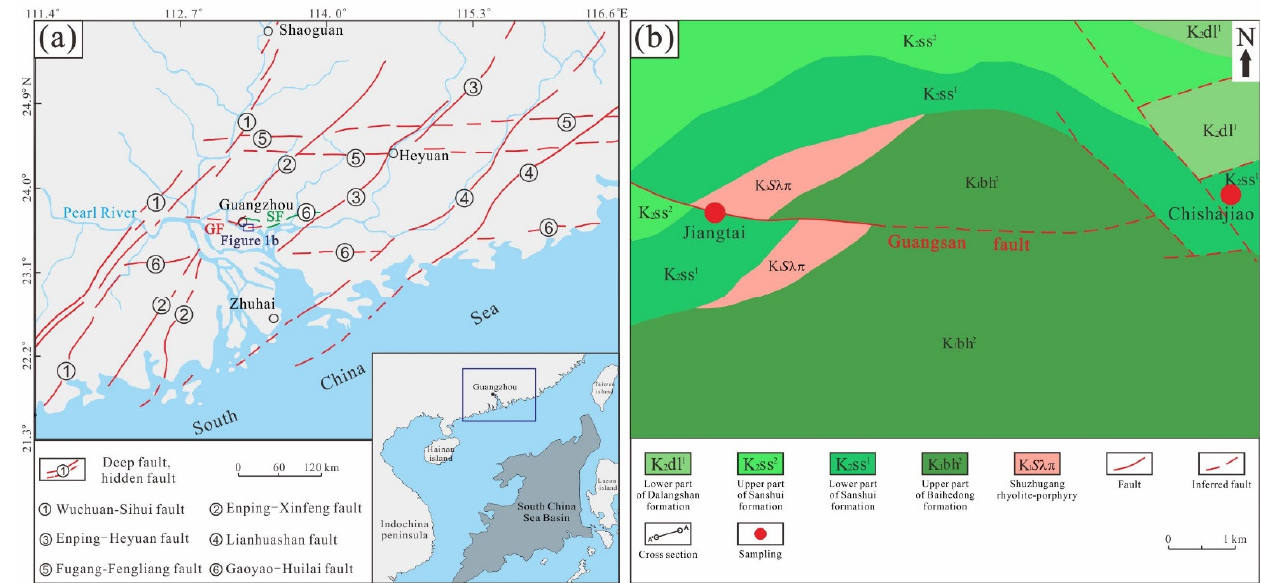
Figure 1. Geological map of the study area. ( a ) Location map of Gaoyao–Huilai fault in Guangdong province, China (modified from [24,25]). Figure 1b indicated to geological map of the study area. GF: Guangsan fault; SF: Shougouling fault. ( b ) Geological map of the study area (modified from [26]).